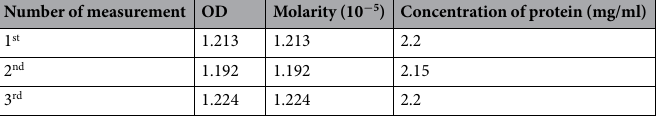
Table 1. Absorbance values of specific IgY antibodies obtained from the eggs of immunized